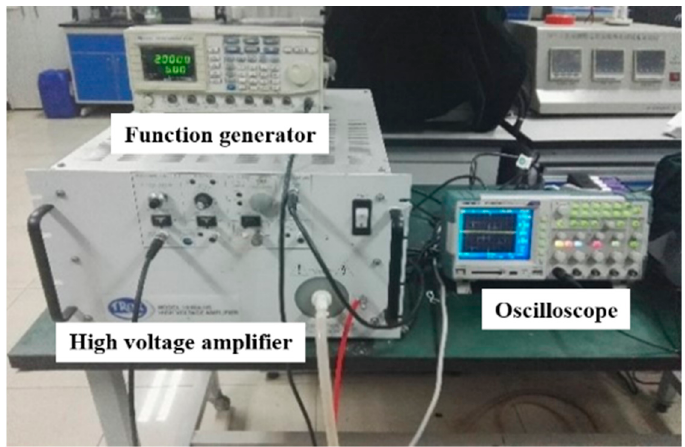
Figure 4. High frequency/high voltage pulse AC power system. During the experiment, the W/O simulated emulsion was generated by using 10# white oil, water and Span 80 emulsifier. Firstly, a certain amount of 10# white oil was fed into the emulsion supply tank and the oil was allowed to circulate with a constant flowrate in the experimental process by starting the pneumatic double diaphragm pump. Then, the IKA high shear dispersing machine was started with a certain rotational speed and water and emulsifier was injected into the emulsion supply tank in proportion to generate the W/O emulsion. When the generated emulsion stabilized, the high frequency/high voltage pulse AC power was turned on and specific electric field parameters were set. The varia- tions of the distribution of the water droplet diameters were collected by the FBRM in real-time and were used to evaluate the performance of the compact electrostatic coales- cer. FBRM is the industry-standard measurement technique used for the in-process meas- urement of particles. A highly precise chord length distribution (CLD), sensitive to parti- cle size and count, was reported in real time without the need for sampling or sample preparation. No shape is assumed and the measurement can be applied at full process concentrations in opaque or translucent slurries and emulsions. The method of online in- situ measurement can reduce the negative impact on the accuracy of the measurement results during the dilution process for the sampling if using the traditional method. During the experiment, the influence of electric parameters and flow conditions such as electric field strength, frequency, water content and flow velocity on the novel compact electrostatic coalescer performance were investigated. Meanwhile, the performance of the electrostatic coalescer with parallel-plate electrodes was also studied and the results were compared with that of the novel compact electrostatic coalescer. 4. Results and Discussion 4.1. Research on Characteristics of Test Emulsion System Since the experiment is conducted by circulating the W/O emulsion in the flow loop with various electric parameters, it is necessary to ensure the reliability and repeatability of experimental results. In order to determine the effect of increased shear time and en- hanced emulsion stability on the experimental results of electrostatic coalescence equip- ment, the experiment was repeated several times with the same W/O emulsion and same electric parameters. Figure 5 shows the variations of water droplet numbers in W/O emul- sion. The vertical axis in Figure 5 represents the number of water droplets within 10 μ m. The horizontal axis in Figure 5 represents the experiment time. The experiment was con- ducted continuously for 30 min. During the experiment, the electric field was powered on and off several times. The electric field strength is 1.8 kV/cm and the frequency is 50 Hz. Figure 6 shows the variations of the average droplet diameter. It can be concluded that once the high voltage power is on, water droplets with diameters less than 10 μ m are